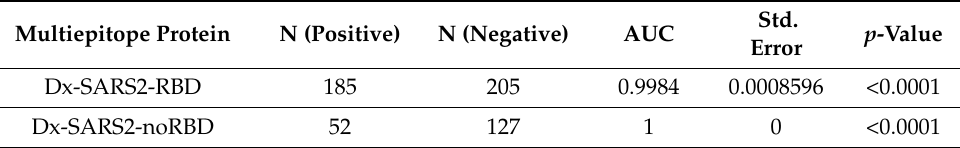
Table 3. Analysis of the area under the curve for the ELISAs with Dx-SARS2-RBD and Dx-SARS2- noRBD.